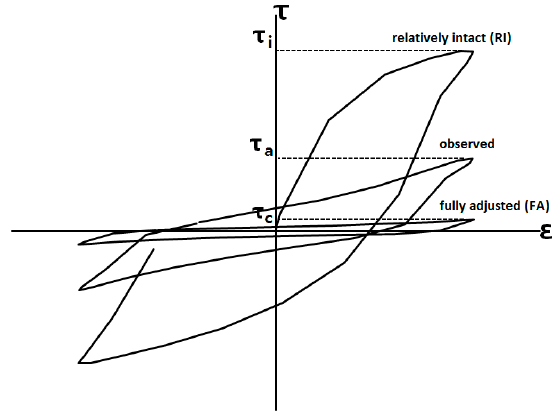
Figure 2. Shear stress of RI, FA, and observed states.